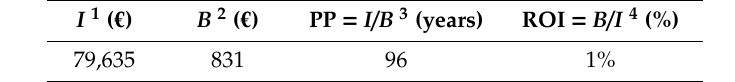
Table 16. Payback period and rate of return as a benefit of reducing national rainwater fees—rainwater